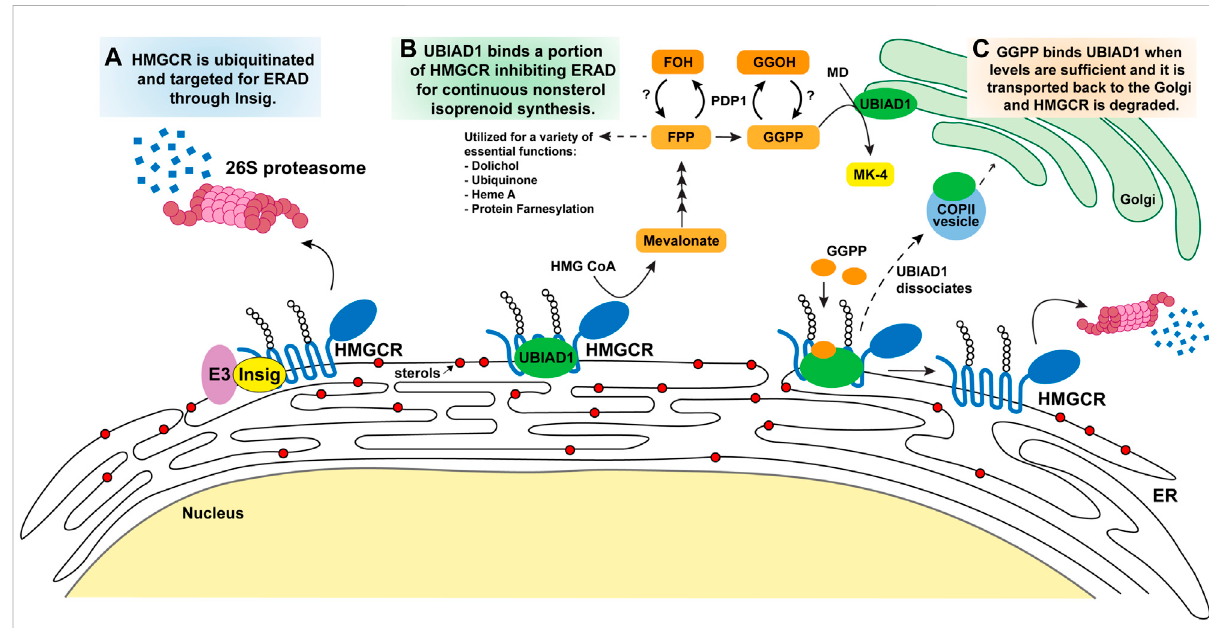
FIGURE 3 Model for the regulatory mechanisms of HMGCR and UBIAD1 by the mevalonate pathway. Accumulation of intracellular sterols (DHL, lanosterol, and certain oxysterols all represented as red circles) in the ER membrane (A) trigger Insig binding to the membrane domain of HMGCR. Insig-associated E3 ligases ubiquitinate HMGCR on cytosolic lysine residues (K89, K248) marking the protein for degradation by 26S proteosomes and subsequently diminishing mevalonate production and fl ux through the pathway. (B) Following Insig-mediated ubiquitination of HMGCR, a subset ofHMGCRmolecules isboundbyUBIAD1 thereby inhibiting itsERAD.This allowsthecell to continue to synthesize alow level of mevalonate for nonsterol isoprenoids necessary for cellular processes illustrated in Figure 1. GGPP is the last nonsterol isoprenoid produced and serves as a feedback molecule. (C) As GGPP levels increase to suf fi cient levels it binds UBIAD1 that is complexed with HMGCR, triggering UBIAD1 dissociation from HMGCR, and UBIAD1 is transported from the ER to the Golgi in COPII vesicles. HMGCR released from UBIAD1 is subjected to